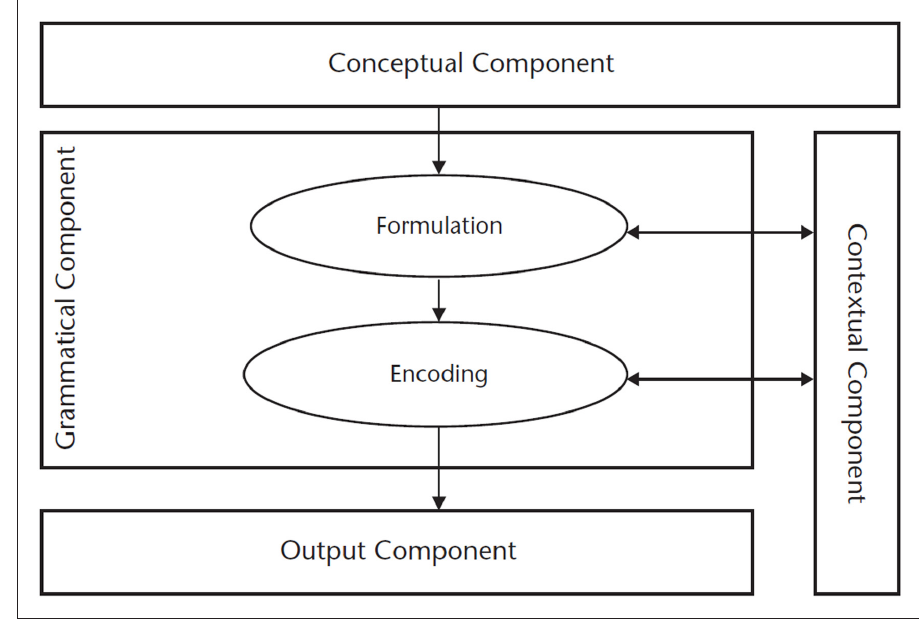
Figure 1: FDG as part of a wider theory of verbal interaction (Hengeveld & Mackenzie, 2008, p.